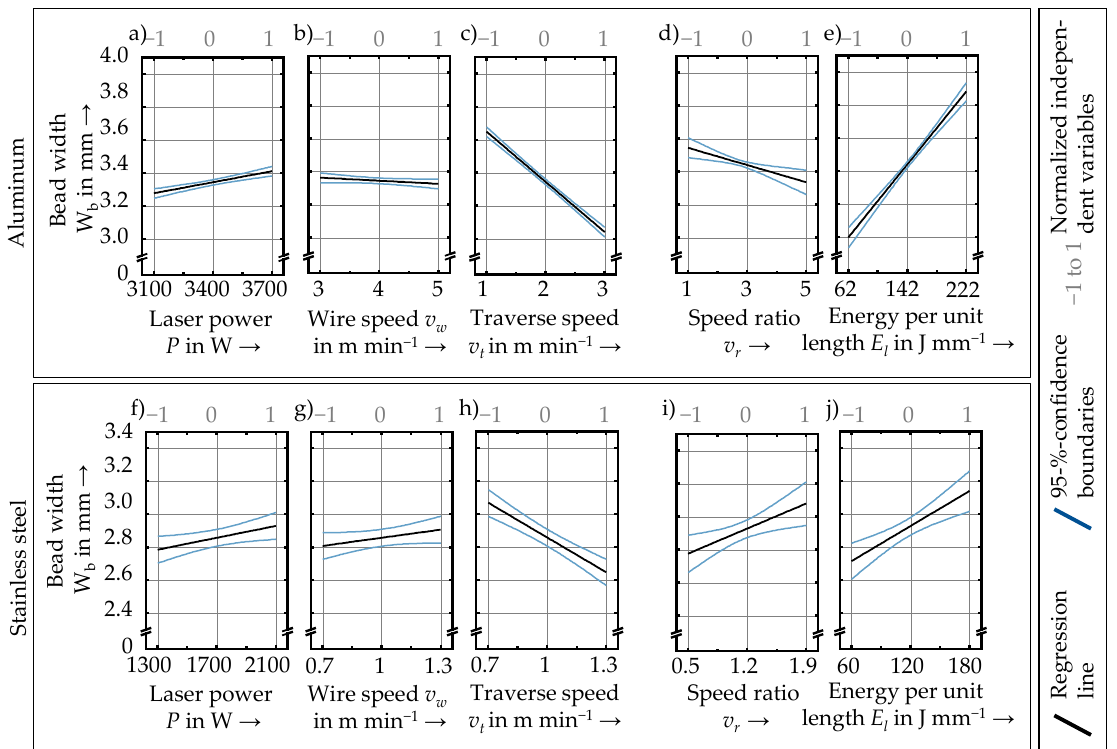
Figure 9. Main effects of the process parameters on the bead width of aluminum (upper row) and stainless steel (bottom row) samples; the single linear models used the independent variables laser power, wire speed, and traverse speed ( a – c ) and ( f – h ) or the independent variables speed ratio and energy per unit length ( d , e ) and ( i , j